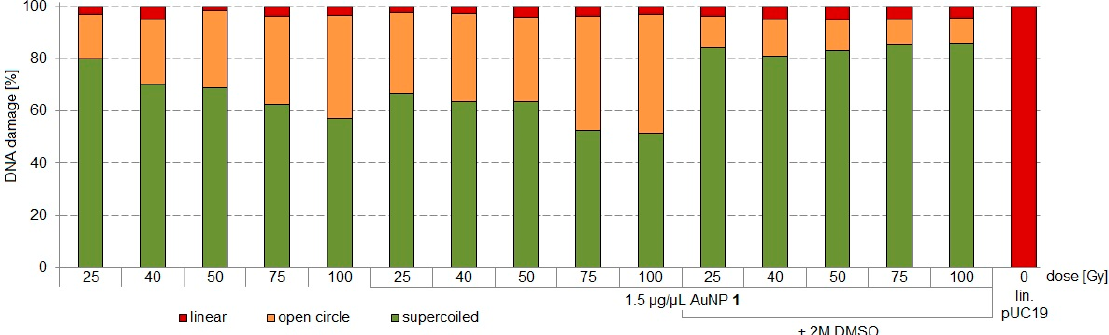
Figure 3. Irradiation experiments applying different doses of 25, 40, 50, 75, and 100 Gy for pUC19 only, pUC19 with AuNPs 1, and pUC19 with AuNPs 1 in presence of 2 M DMSO. sc pUC19 is expressed as green bar, the extent of oc is expressed in orange, and the extent of lin plasmid in red.